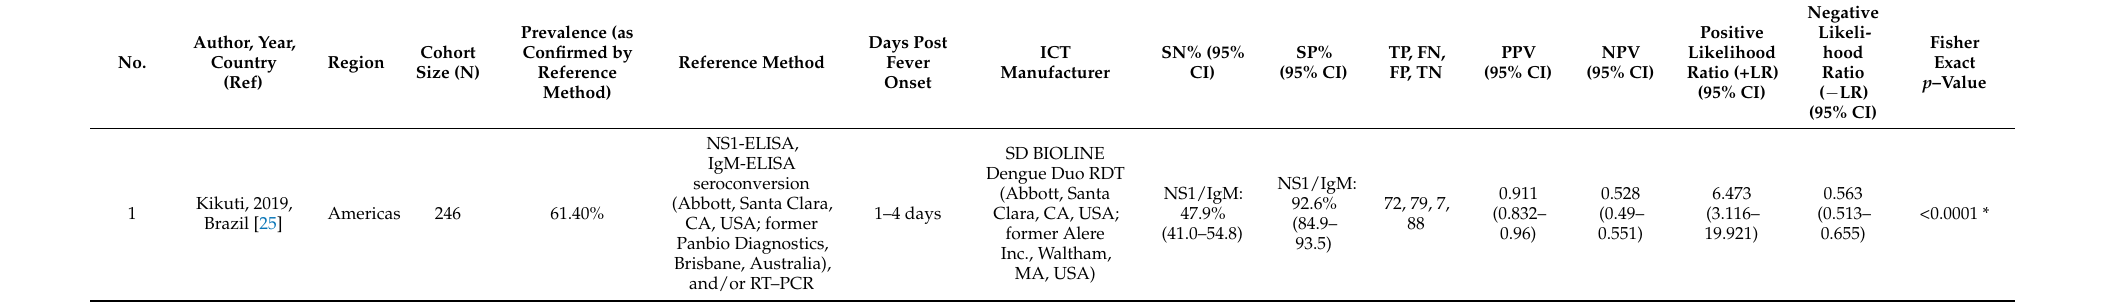
Table 5. NS1/IgM Summary Findings of Post–Hoc